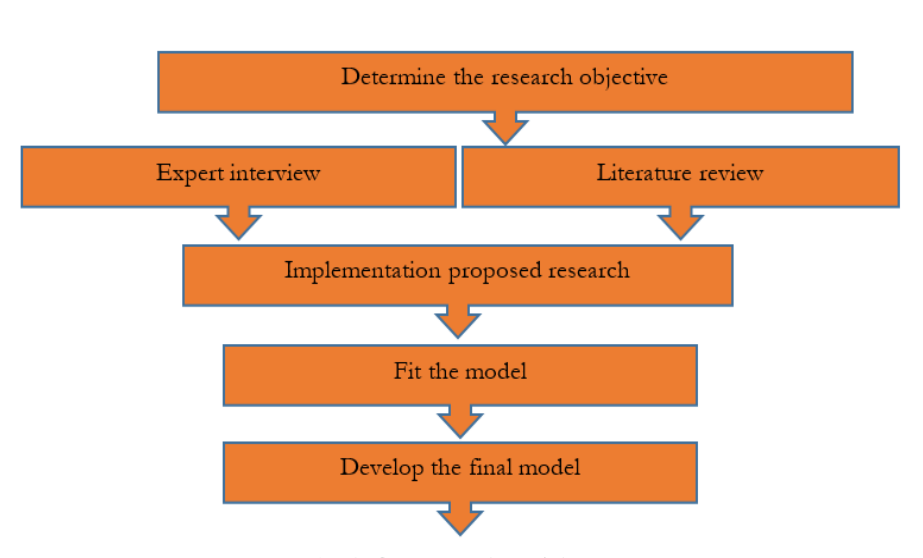
Fig. 1. Conceptual model.